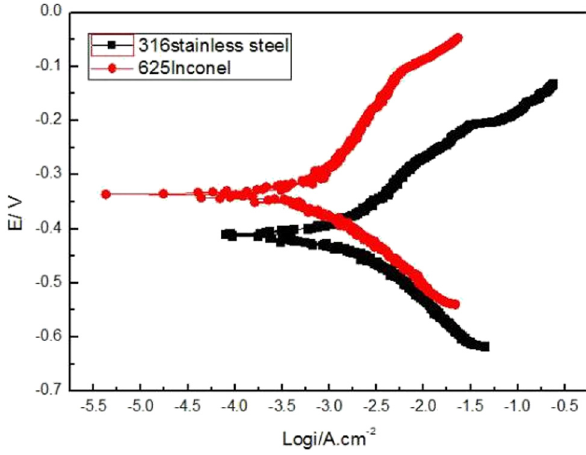
Figure 7: Potentiodynamic polarization curves of 316 ss and Inconel 625 alloy in ternary chloride molten salt at 700°C.